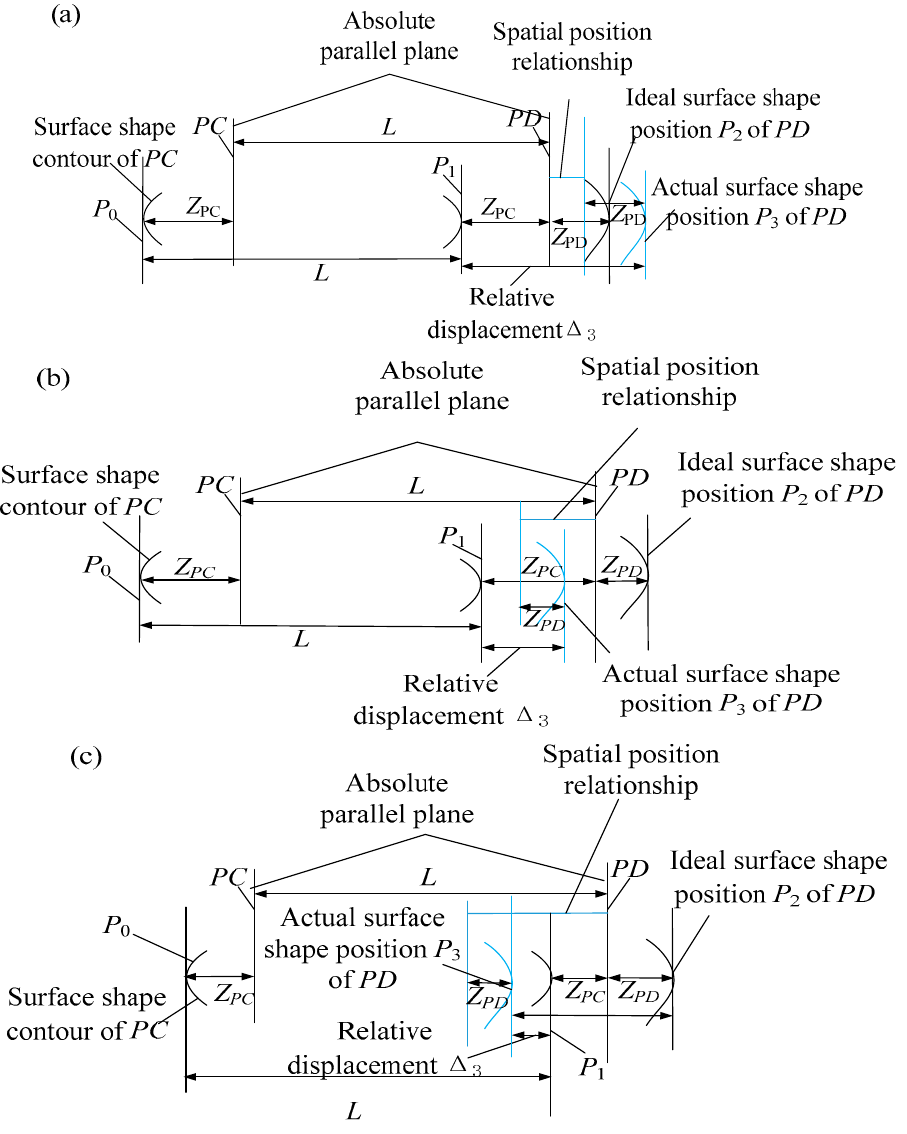
Figure 14. Separation algorithm model of the combined projection curve: ( a ) Model 1; ( b ) Model 2; ( c ) Model 3.